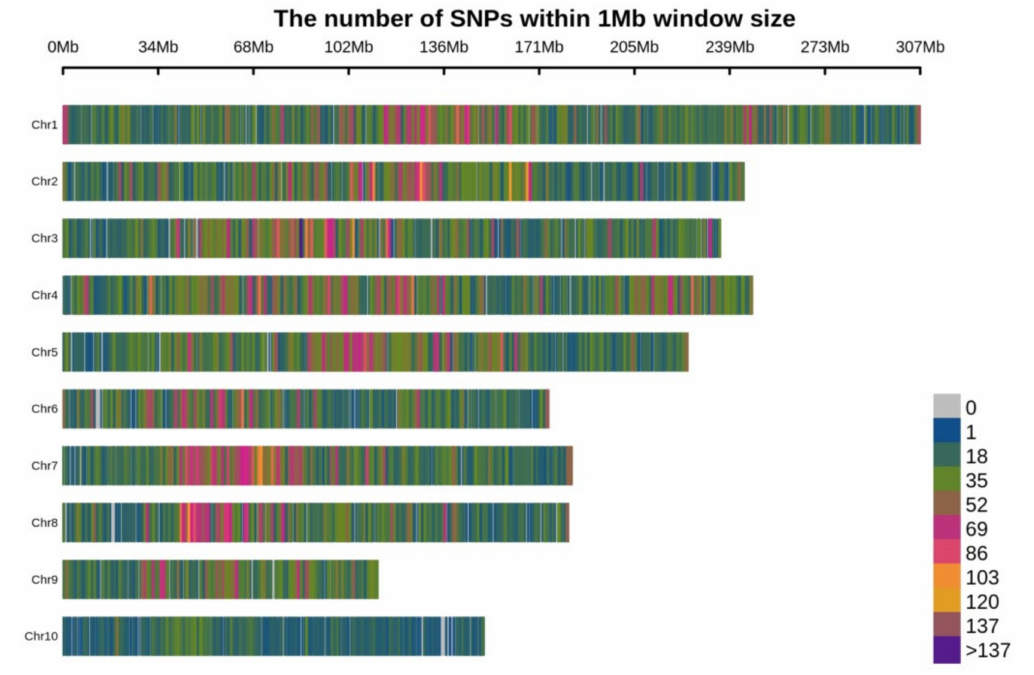
Figure 2. Distribution of SNPs used in the study on ten maize chromosomes. The horizontal axis shows the physical distance with the different colors reflecting the SNP density distribution. Table 2. Summary of transition and transversion mutations detected among 384 maize